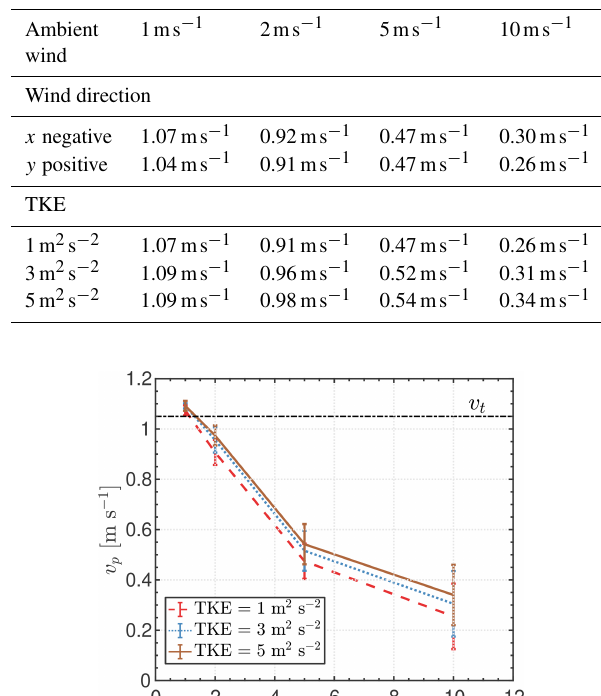
Table 3. Mean particle fall speed for various wind directions, wind speeds, and TKE values. The terminal fall speed is 1.05ms − 1 in all runs.